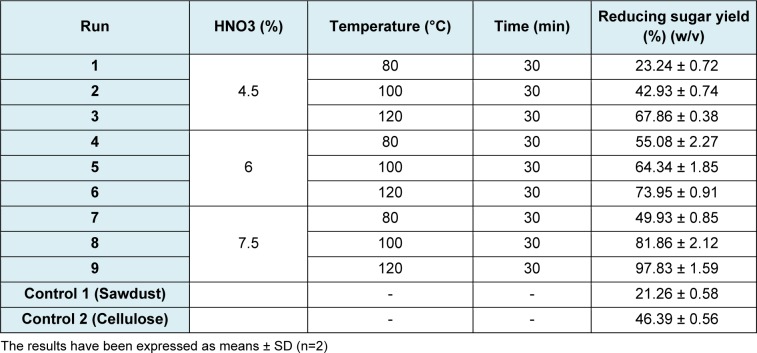
Design matrix (32) of hydrolysis and results